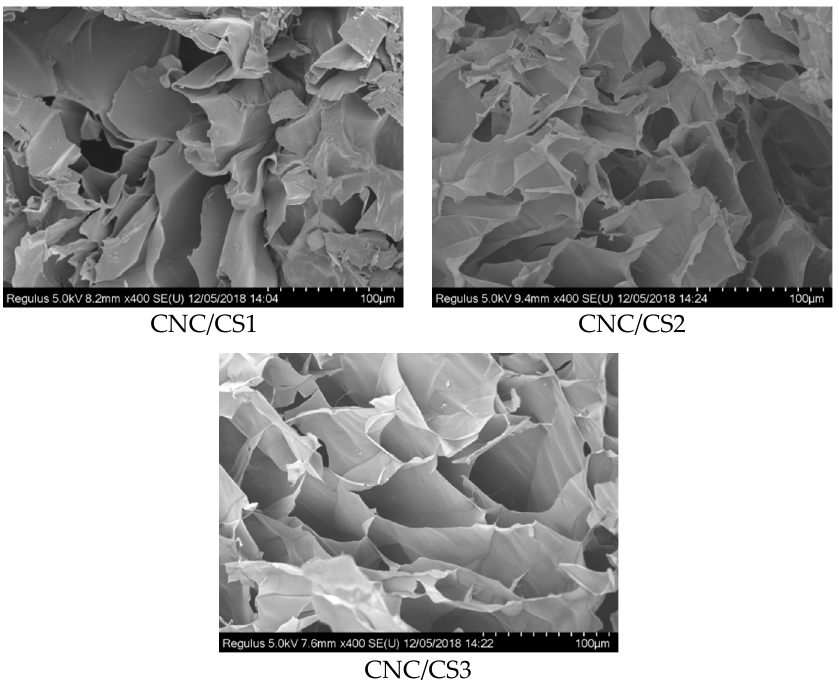
Figure 5. FE-SEM images of CNC/CS1, CNC/CS2, and CNC/CS3. The hydrogels were freeze-dried to form aerogels, which were highly porous and lightweight, with a density of 0.0188, 0.0191, and 0.0205 g/cm 3 for CNC/CS1, CNC/CS2, and CNC/CS3, amounts of CNC and high porosity. The morphology of freeze-dried CNC/CS1, CNC/CS2, and exhibited porous and interconnected microstructures. The pore size increased as the chitosan percentage increased. The gradual increase in pore size of the hydrogels could have been due to the